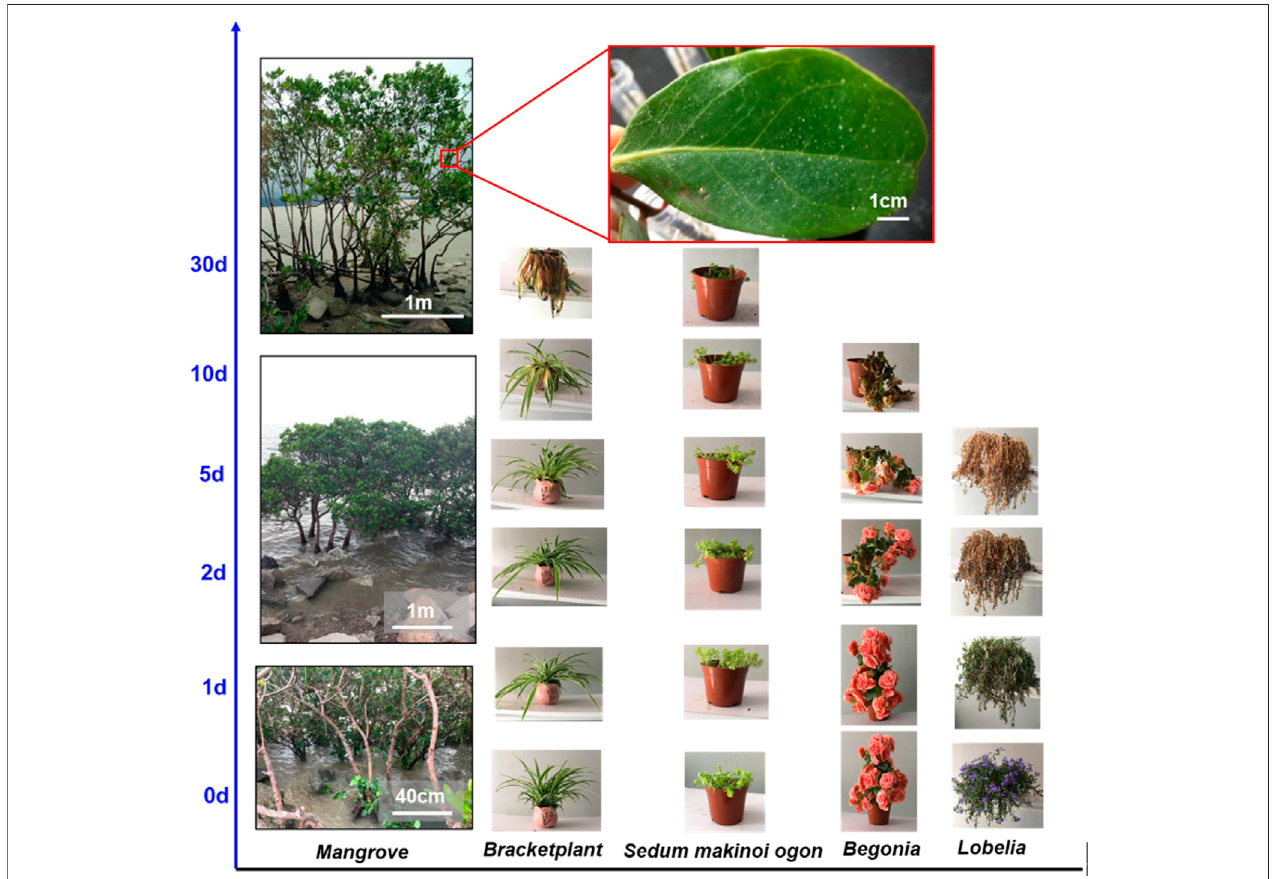
FIGURE 1 | Salt-resistant mangrove in comparison with other four types of common plants: their growing conditions under salted water supply with increasing culture time. The mangrove lives well and the leaves show deposited salt particles, while the four common plants ( Bracketplant , Sedum makinoi ogon , Begonia , and Lobelia ) gradually withered/died from the 5th day (d) up to the 30th